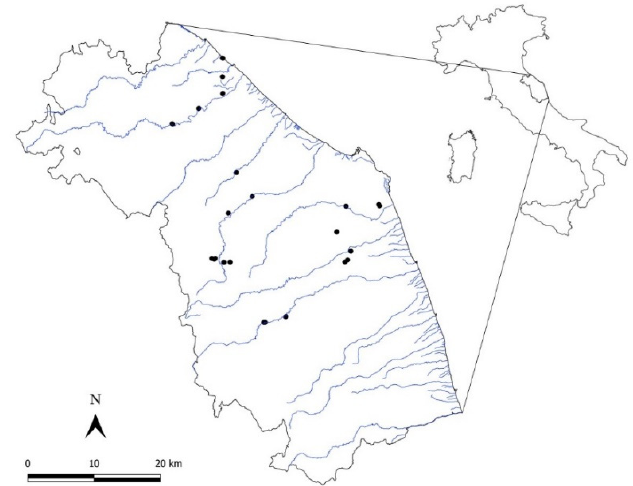
Figure 6. Location of the study area in sub-Mediterranean central Italy, showing the distribution of the paired sampling units. Each pair of sampling is represented by a single black point.